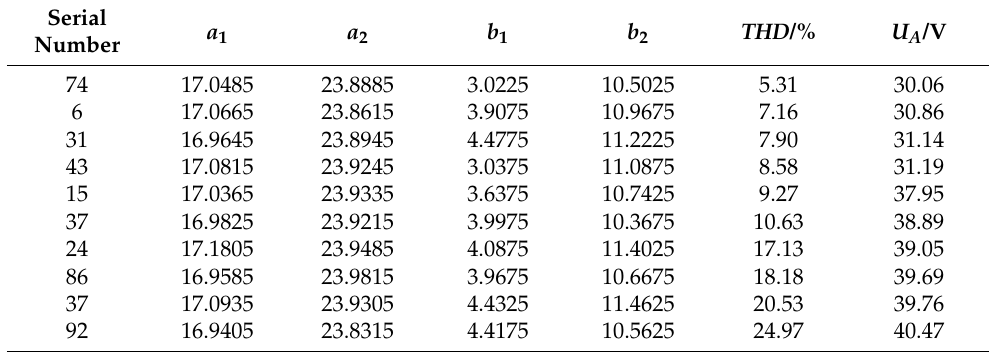
Table 5. The specific values of design variables and optimization objectives in the effective solution.